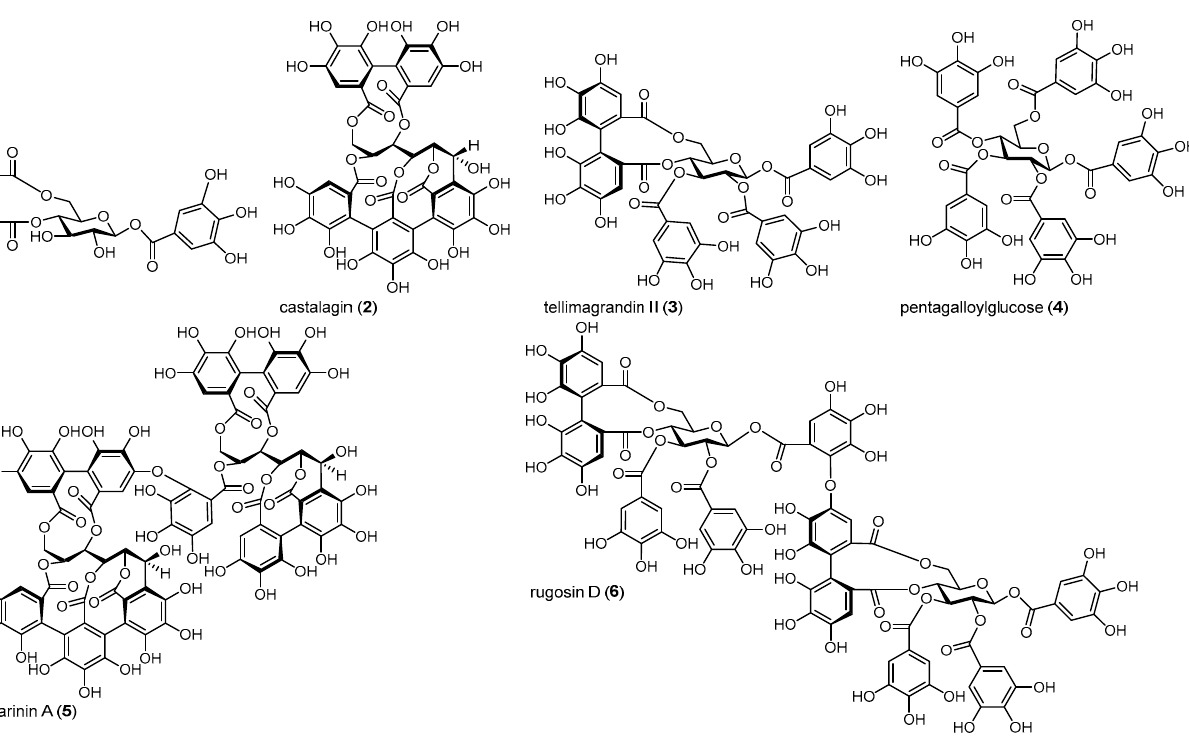
Figure 1. Structures of hydrolyzable tannins used in this study: 1 , strictinin; 2 , castalagin; 3 , tellimagrandin II; 4 , pentagalloylglucose; 5 , salicarinin A; and 6 , rugosin D.